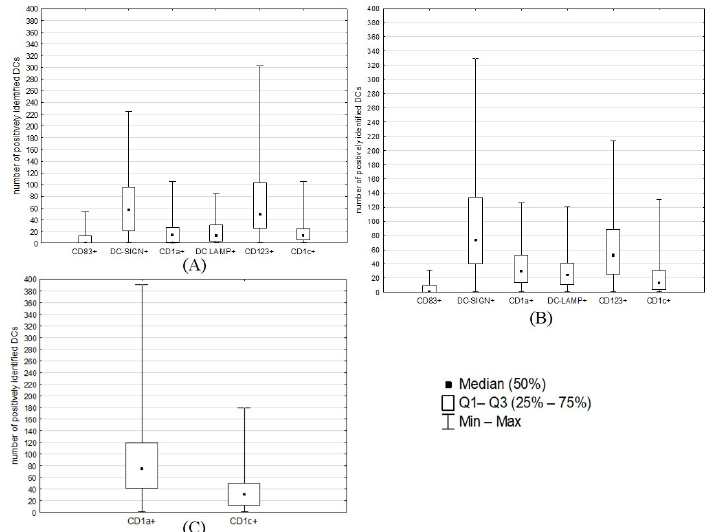
Figure 4. Median counts (/mm 2 ) of DC subtypes in different areas of cancerous tissues: ( A ) invasive margin; ( B ) tumor stroma; ( C ) tumor glands (CD1a+ and CD1c+ DCs were the only DC subtypes found in glandular epithelium). The graph shows the median, minimal, and maximal numbers of DCs positively stained for different antibodies (counted in five fields of view) as well as values of quartile 1 (Q1) and quartile 3 (Q3) that were used to divide samples into groups for further analysis. EC samples were initially examined at 10 × magnification; within areas that were most abundant in positively identified DCs, their numbers in five representative fields of view were summed up at high (40 × ) magnification and expressed per 1 mm 2